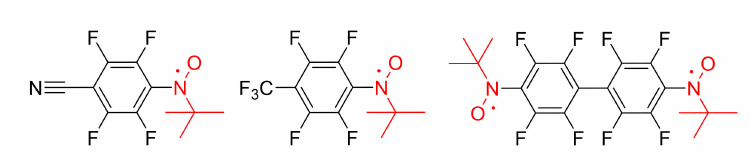
Figure 1. Synthesized polyfluorinated tert